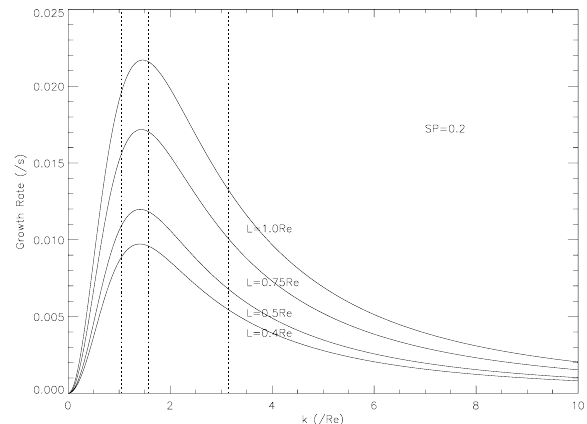
Fig. 3. Background number density in the domain ( L = 0 . 75 R E ). Each labeled line indicates an unstable domain. Ends of each line indicate the boundaries of the domain.